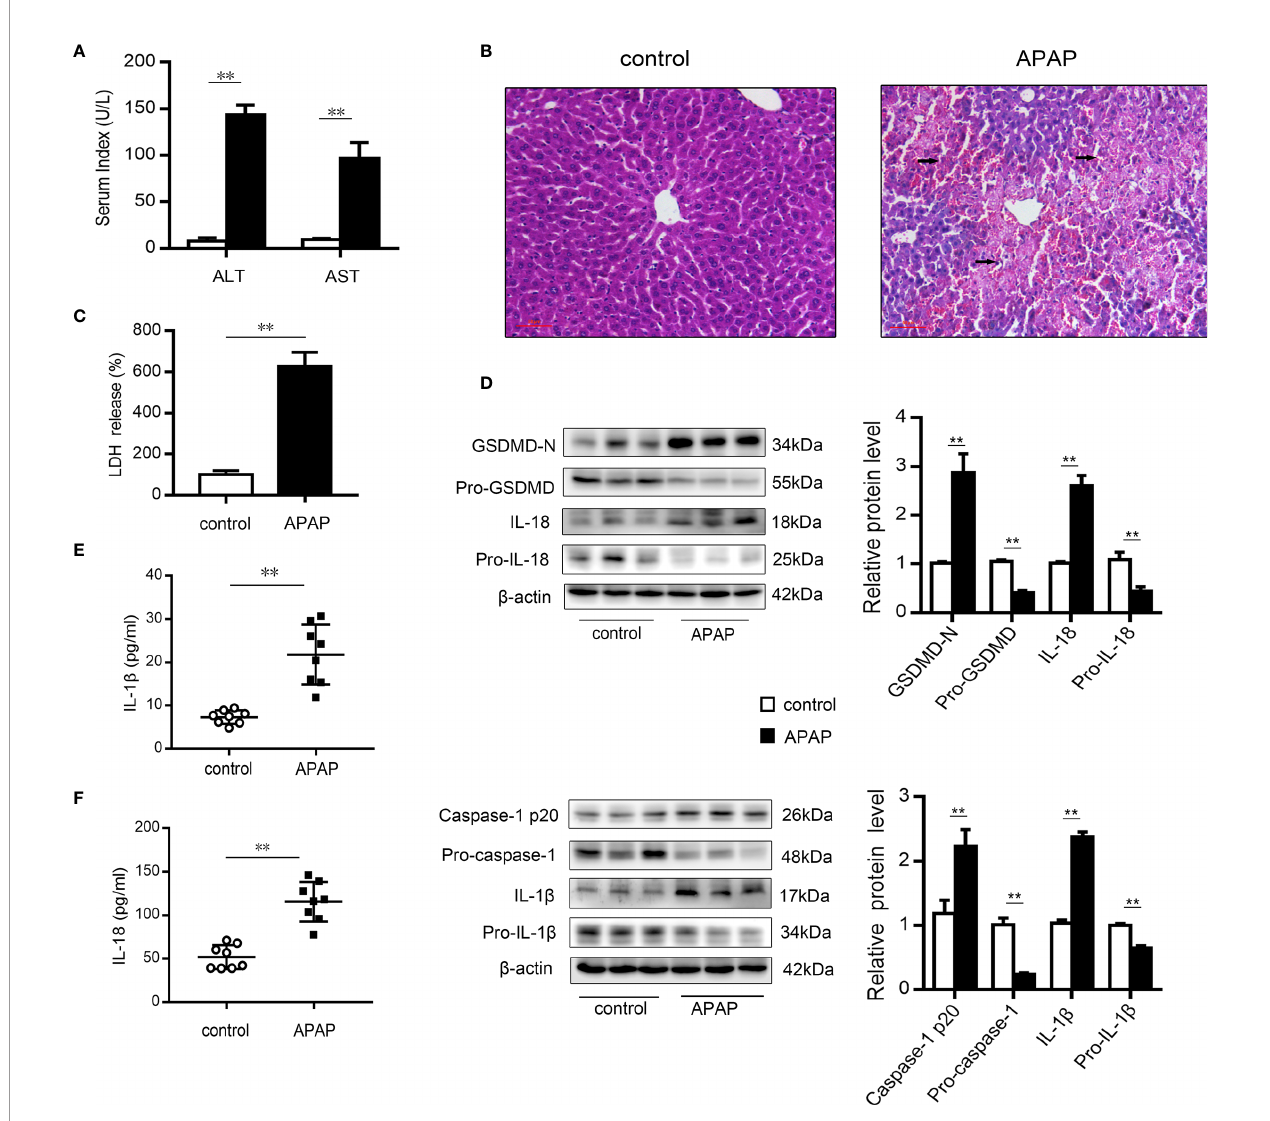
FIGURE 1 | Pyroptosis occurs in mice with APAP-induced liver injury. Liver and serum samples were obtained from mice treated with APAP (300 mg/kg) for 12 h. (A) Serum levels of ALT and AST were assessed, n=8. (B) Liver sections were stained with H&E (50 m m), and the damaged area are indicated with arrows. (C) Serum levels of LDH were assessed, n=8. (D) Pro-GSDMD/GSDMD-N, pro-caspase-1/caspase-1 p20, pro-IL-1 b /IL-1 b , and pro-IL-18/IL-18 protein levels in mice liver were determined, n=3. (E) Serum levels of IL-1 b . (F) Serum levels of IL-18, n=8.